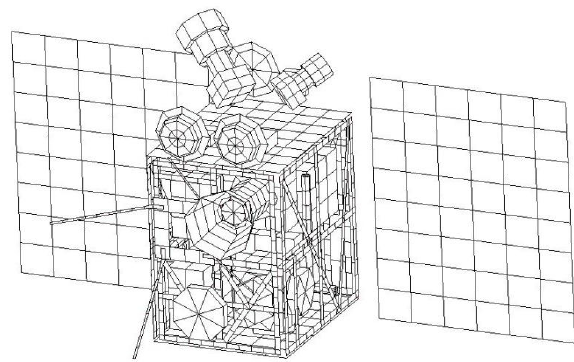
Figure 6. Thermal analysis model of the Luojia 1-01 satellite.